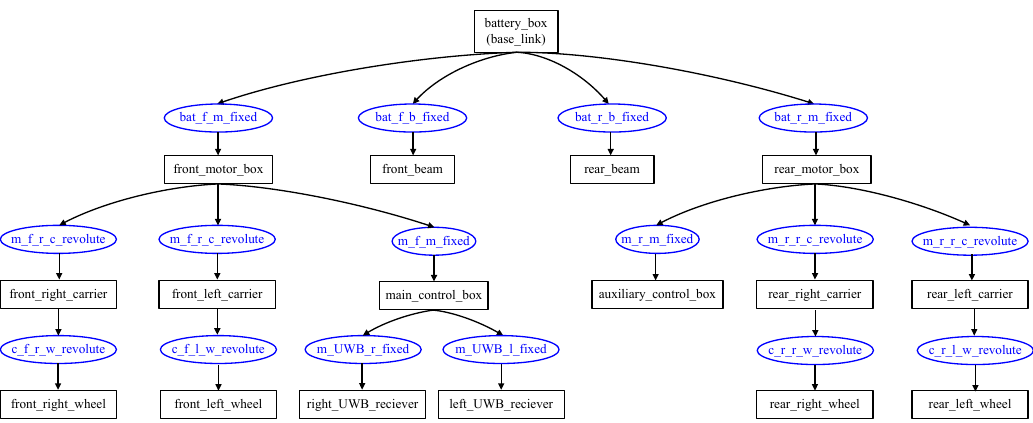
Figure 4. Simulation model of WLR-5A.